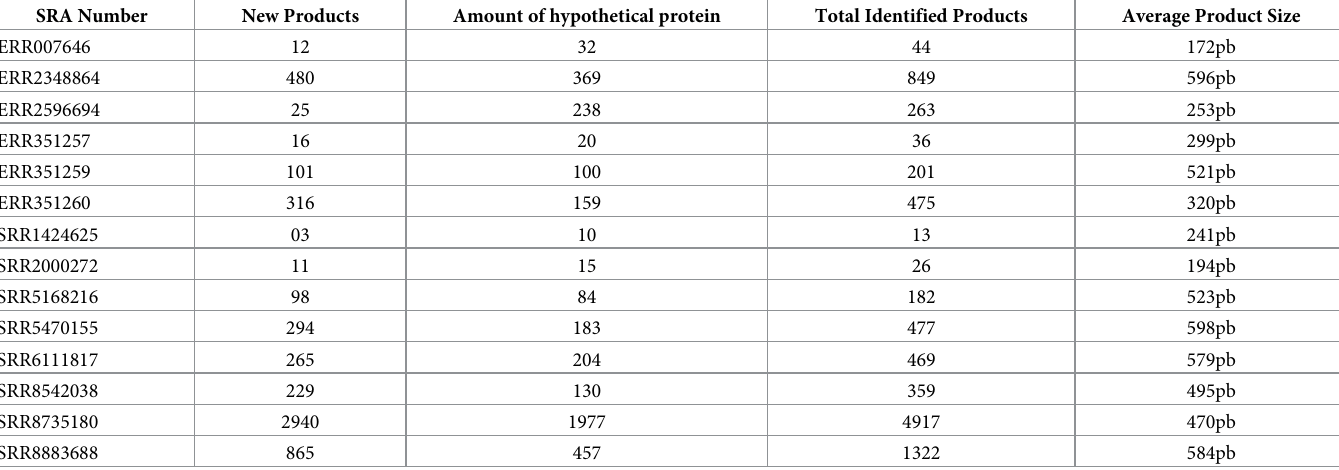
Table 2. List of products identified through the PAN2HGENE pipeline.